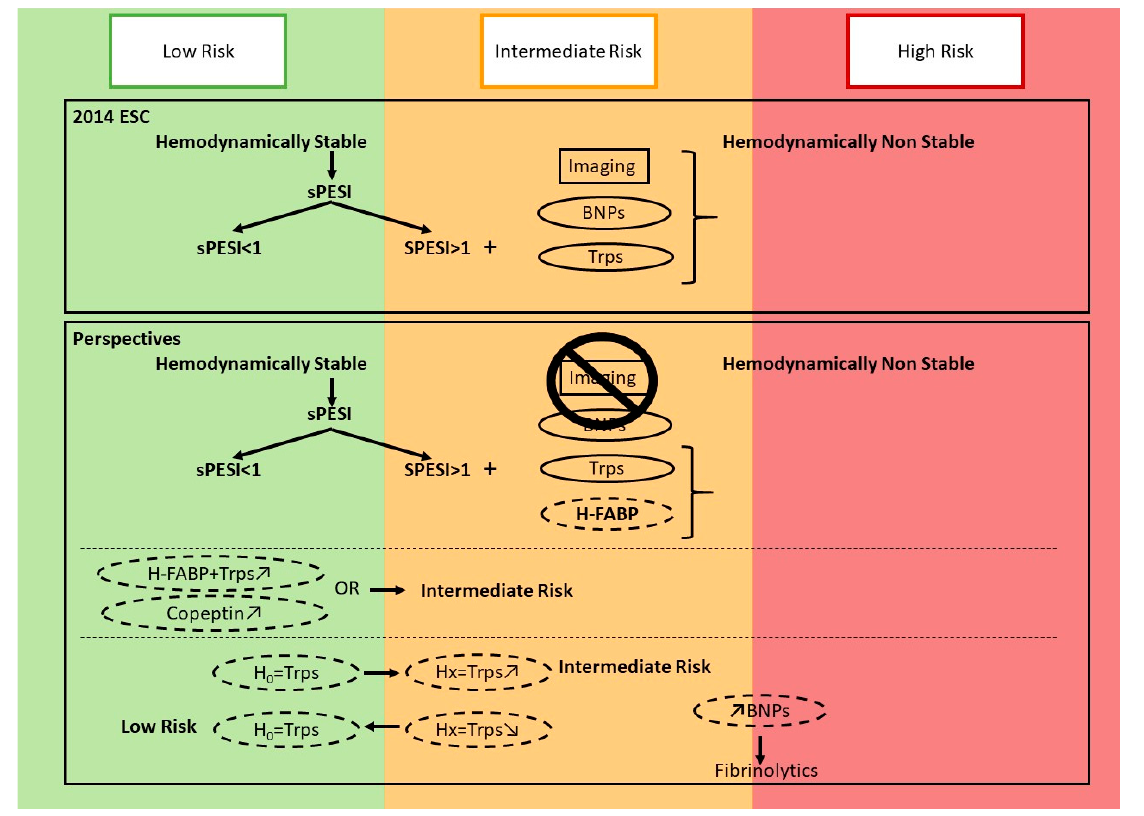
Figure 1. The new potential role of the cardiac biomarkers in acute PE. 5.3. Will Biomarkers Allow Individualization of a Population, in Which There Is an Increased Risk of Initial or Longer-Term